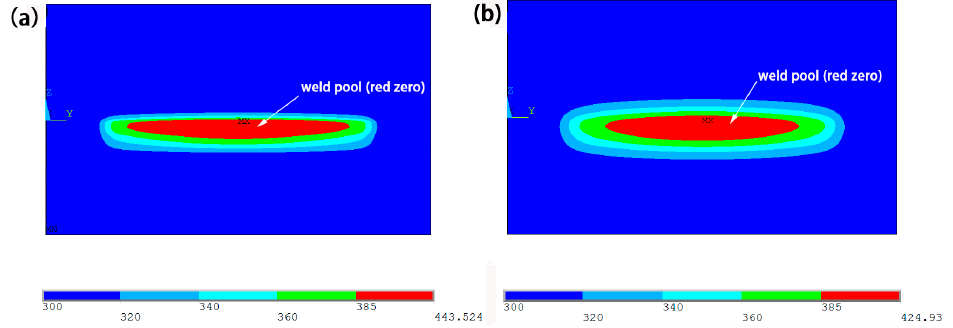
Figure 11. Comparison of weld pool when the peak voltage is 460 V and the defocusing distance is 8 mm. ( a ) type I; ( b ) type II.